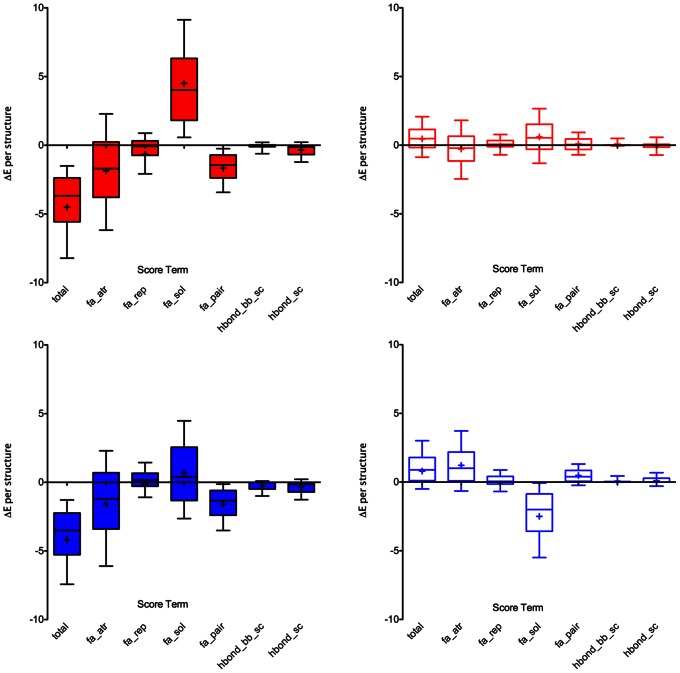
Low-charge variant residue energy changes per structure (600 total) broken down by each weighted score term.
Red: negative-charge variants. Blue: positive-charge variants. Solid bars: Rosetta designs. Empty bars: AvNAPSA designs. AvNAPSA mutations have little effect on computed energy, on average (right, empty bars). Rosetta improves total energy primarily through Lennard-Jones attraction (fa_atr), charge complementarity (fa_pair), and reference energy, and a minor improvement results from addition of hydrogen bonds (left, solid bars). Rosetta mutations lead to increases in solvation energy (fa_sol) for negative supercharging. Not all score terms are included because their values cannot change in fixed backbone design (backbone-backbone hydrogen bonds, disulfides, proline closure, omega angle planarity). total: total residue energy, fa_atr: Lennard-Jones attraction, fa_rep: Lennard-Jones repulsion, fa_sol: Lazaridus-Karplus implicit solvation (penalizes buried polar atoms, slightly rewards buried carbon atoms), fa_pair: knowledge-based statistical term favoring oppositely-charged residues in close proximity, hbond_bb_sc: geometric score for backbone-sidechain hydrogen bonds, hbond_sc: geometric score for sidechain-sidechain hydrogen bonds.